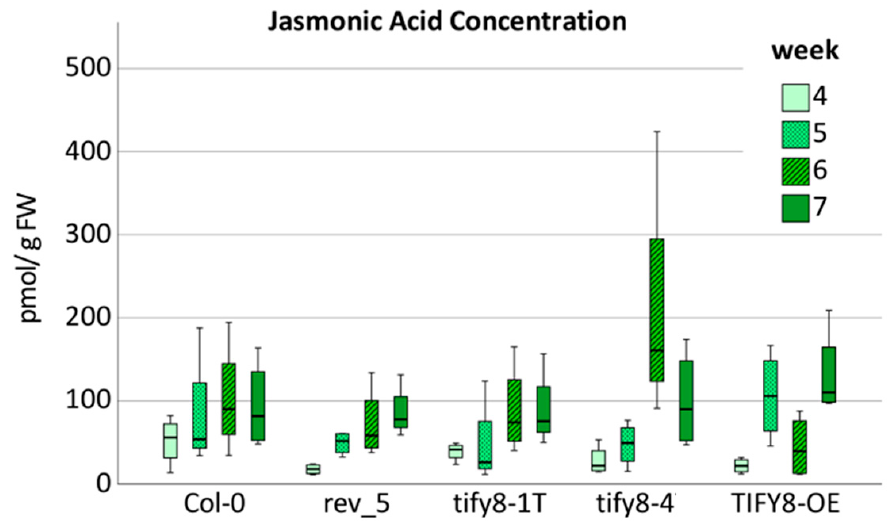
Figure 6. Boxplot of JA concentrations measured by LCMS in Col-0, rev5, tify8-1T , and tify8-4 mutants and TIFY8 -OE plants. The concentration was determined in pools of leaves No. 5 to 9 of 4- to 7-week-old-plants ( n = 4).